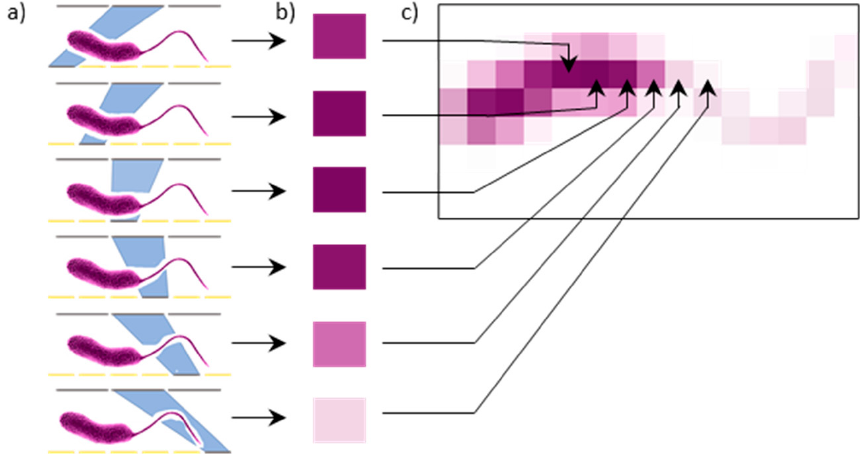
Figure 1. Image formation in NIM and e-STOM. The object is placed on the LED array/microdisplay. Every LED is switched on and off sequentially ( a ), and a detector records the light intensity transmit- ted through the sample ( b ). The image is formed by tiling every detected intensity as associated with the position of the lit LED ( c